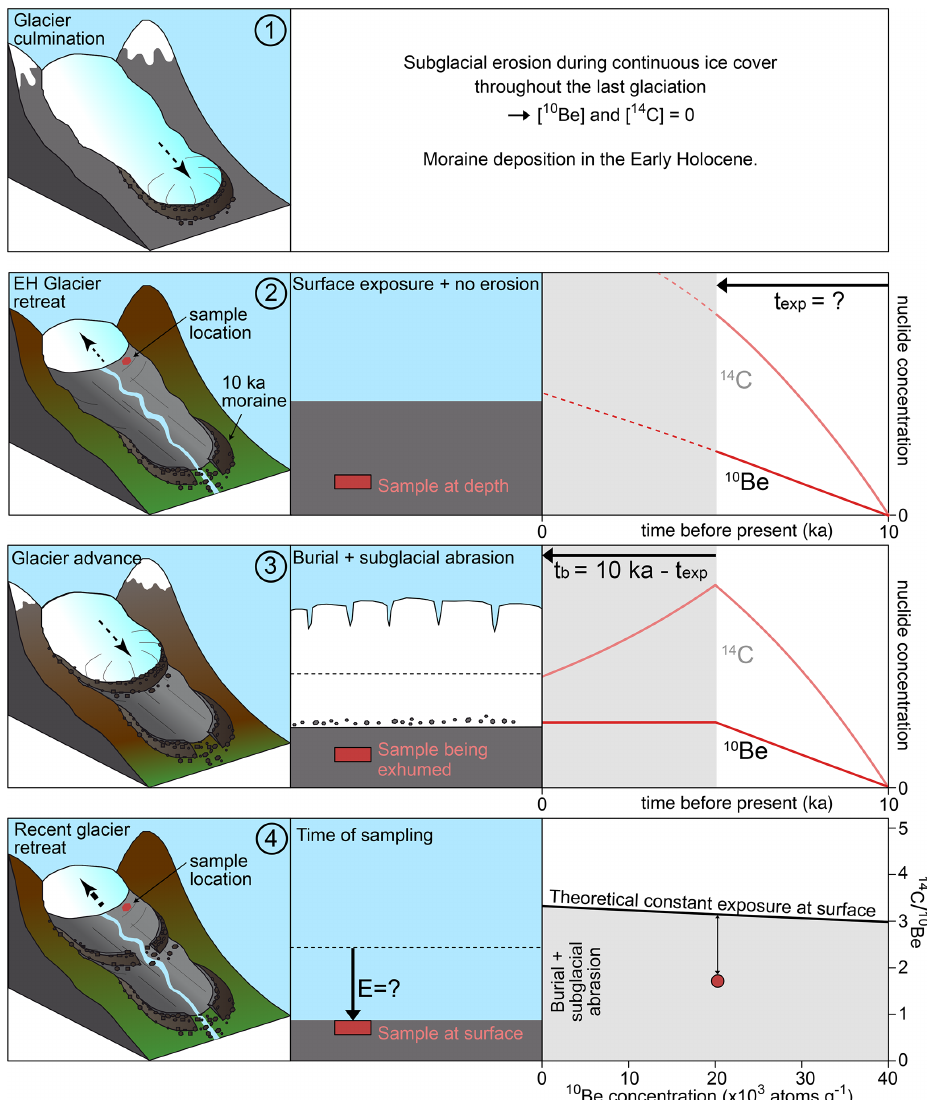
Figure 5. General concept of the in situ 14 C– 10 Be exposure–burial approach. Left panels show a hypothetical scenario of alternating large and retracted glacier extents, covering and uncovering a fictive sample location (red spot). Middle panels depict the position of the sample material (red rectangle) with regard to the bedrock surface. Right panels of stages (2) and (3) illustrate the trajectories of the in situ 14 C and 10 Be concentrations in the sample during its exposure and advection (exhumation) towards the surface (Lagrangian perspective; see Sect. 3.5). Stage (1): subsequent to continuous ice cover and deep subglacial erosion during the last glaciation, the bedrock is free from cosmogenic nuclides. Deposition of the early Holocene (EH) moraines and subsequent glacier retreat constrains the beginning of the Holocene glacier retreat, i.e., 10ka in this example. Stage (2): the sample location is exposed for an unknown duration t exp , with the sample material remaining at the same depth (no surface erosion), where 14 C and 10 Be accumulate constantly. Stage (3): the sample location is buried by ice, which abrades the bedrock surface, thus progressively exhuming the sample material. No production of 14 C and 10 Be due to shielding by ice cover. Radioactive decay leads to steady loss of 14 C (short half-life of 5.7kyr) but does not affect the 10 Be concentration due to the long half-life of this nuclide of 1.4Myr. The burial duration t b is equal to the timing of initial EH glacier retreat minus t exp . The dashed line represents the initially exposed surface elevation. Stage (4): exposed since the recent glacier retreat, the sample material is now at the surface where it is collected. E represents the unknown erosion depth, i.e., the thickness of rock layer that was removed by abrasion during stage (3). The lowest right panel shows a two-isotope plot with the thick black line representing continuous exposure ( 14 C / 10 Be ratio =∼ 3) and the grey area burial and subglacial abrasion ( 14 C / 10 Be ratio < 3). The 14 C / 10 Be ratio and 10 Be concentration of the fictive sample is plotted as a red dot.